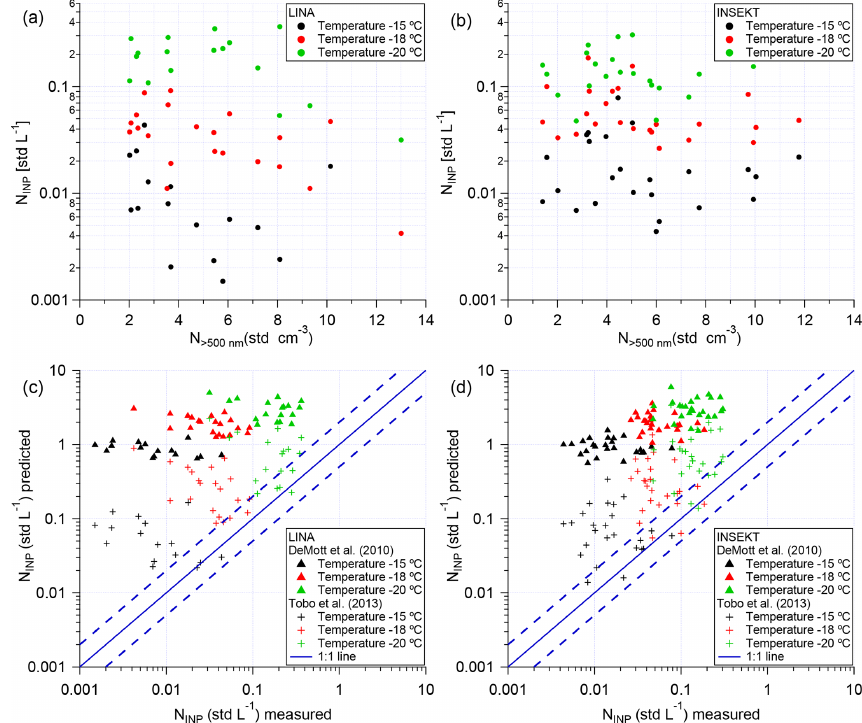
Figure 12. Scatter plot of N INP measured by LINA (a) and INSEKT (b) against N > 500nm . Scatter plot of N INP measured by LINA (c) and INSEKT (d) against the N INP predicted by DeMott et al. (2010) and Tobo et al. (2013). The dashed lines outline a range of a factor of 2 about the 1 : 1 line (solid